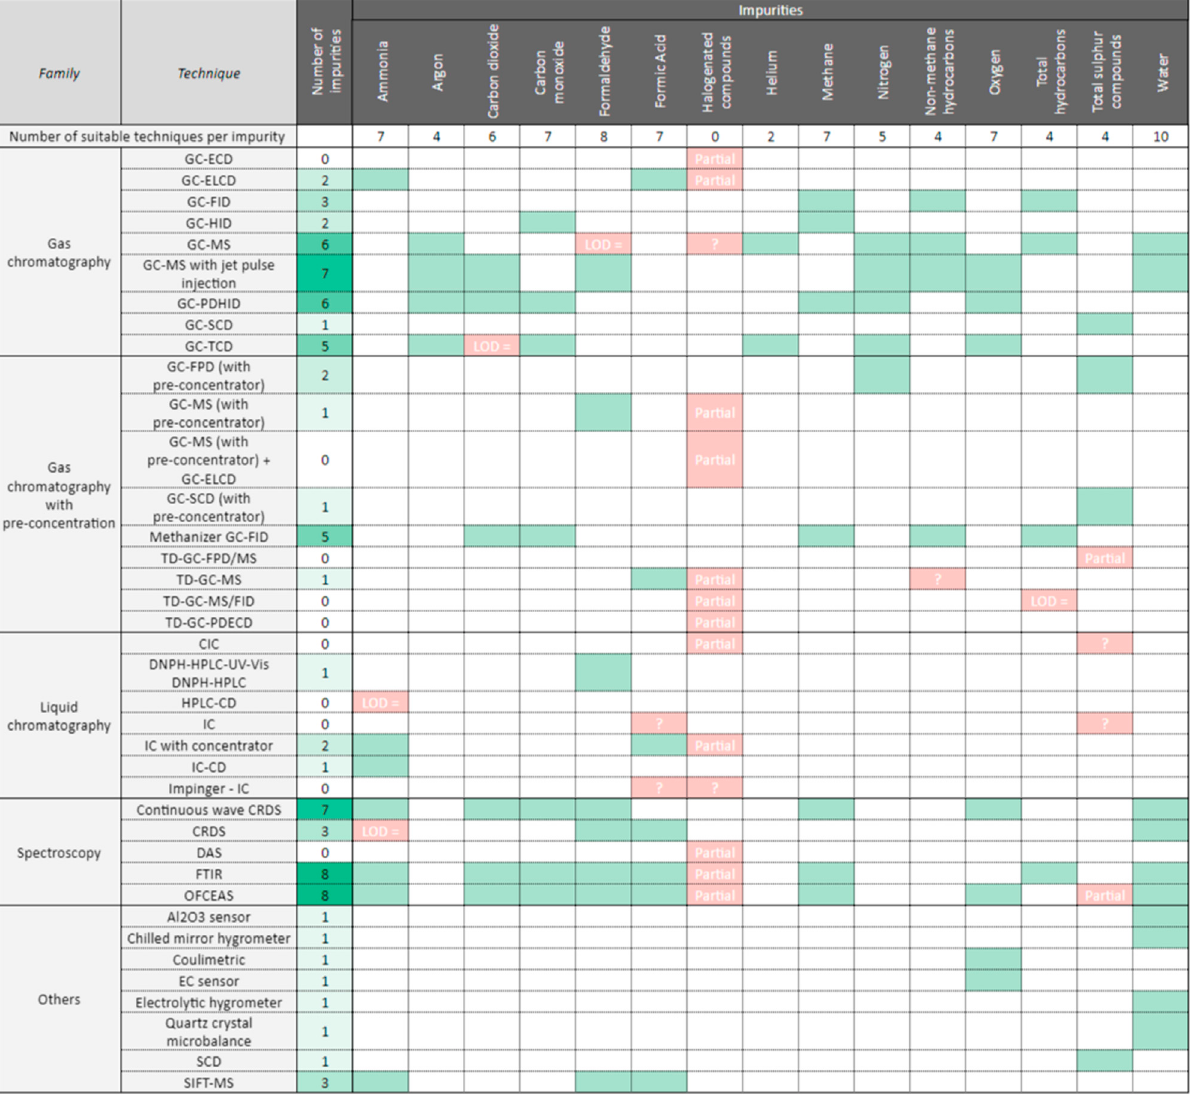
Frontiers in Energy Research |